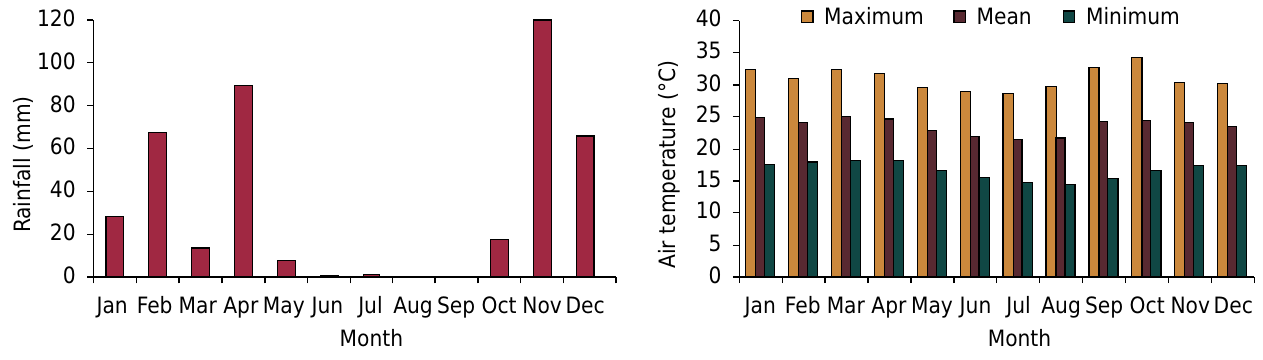
VCS: very coarse sand; CS: coarse sand; MS: medium sand; FS: fine sand; VFS: very fine sand; TS: total sand; BD: soil bulk density; Mp: macroporosity; mp: microporosity; and TP: total porosity. Particle size analysis determined by the pipette method (Gee and Or, 2002). BD determined by the volumetric ring method. Mp and mp by the tension table method, and TP by the sum of Mp and mp.